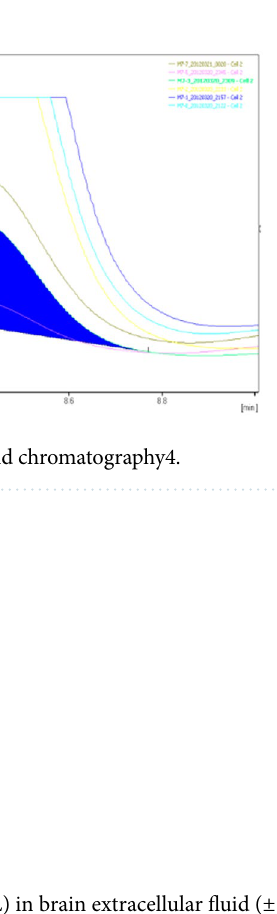
Figure 14. GABA high performance liquid chromatography3.